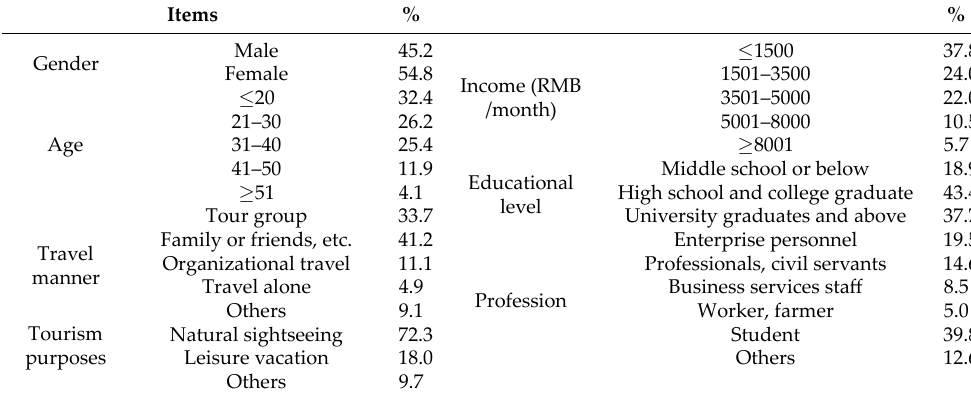
Table 2. Sample characteristics (N =